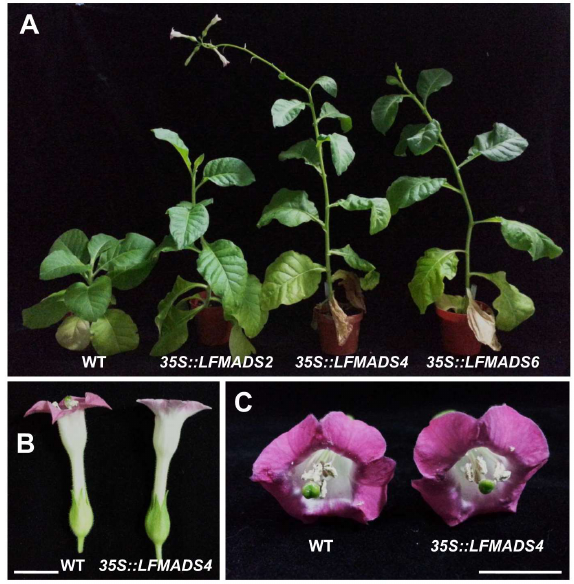
Figure 11. Phenotypic analysis of 35S::LFMADS2 , 35S::LFMADS4 , and 35S::LFMADS6 transgenic tobaccos. ( A ) Overexpression of LFMADS2 , LFMADS4 , and LFMADS6 promotes flowering in tobaccos under the long-day condition. ( B , C ) Phenotypic analysis of floral organs of WT and 35S::LFMADS4 transgenic tobaccos. No obvious difference in morphology, shape, arrangement, and color is shown in terms of floral organ between WT and transgenic tobacco. Bar = 1 cm.